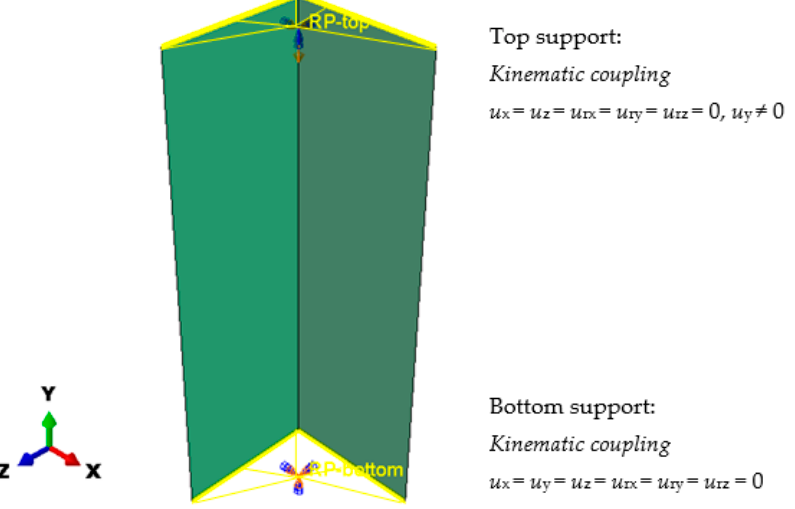
Figure 2. Geometry of a typical stub column model and applied boundary conditions and constraints.